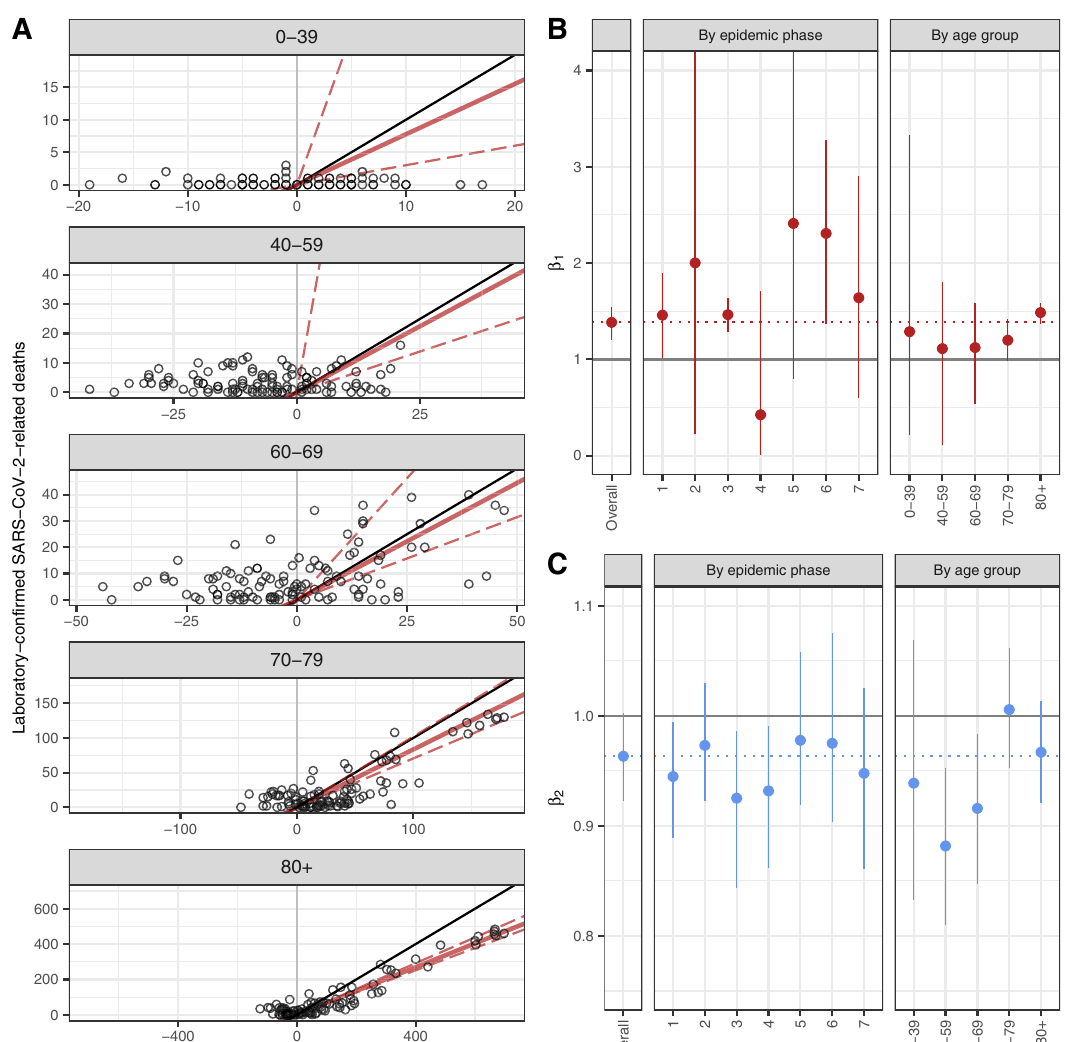
Fig. 3 | Direct ( β 1 ) and indirect ( β 2 ) effects of the COVID − 19 pandemic and all- cause mortality by age and epidemic phase. A Association between weekly laboratory-con fi rmed COVID-19-related deaths and absolute excess mortality by age group. The black line shows the slope of association corresponding to a 1 to 1 relation. The red lines show the association estimated with the model (corre- spondingtothe β 1 coef fi cientsshowninpanel( B ),thefulllinerepresentsthepoint estimate and the dashed lines the lower and upper bounds of the 95% credible interval). B Estimatesof β 1 ,theadditionalnumberofdeathstobeobservedforeach